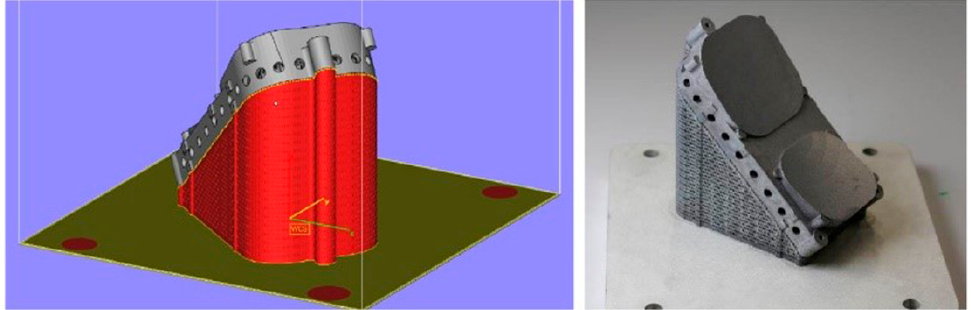
Figure 11. Sketch map of support design [46].